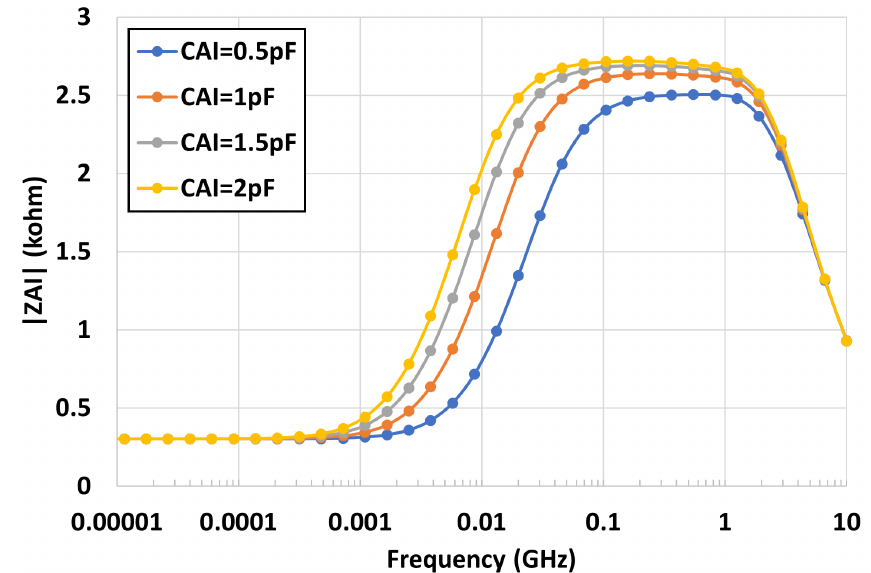
Figure 6. Magnitude of Z AI for different values of C AI .